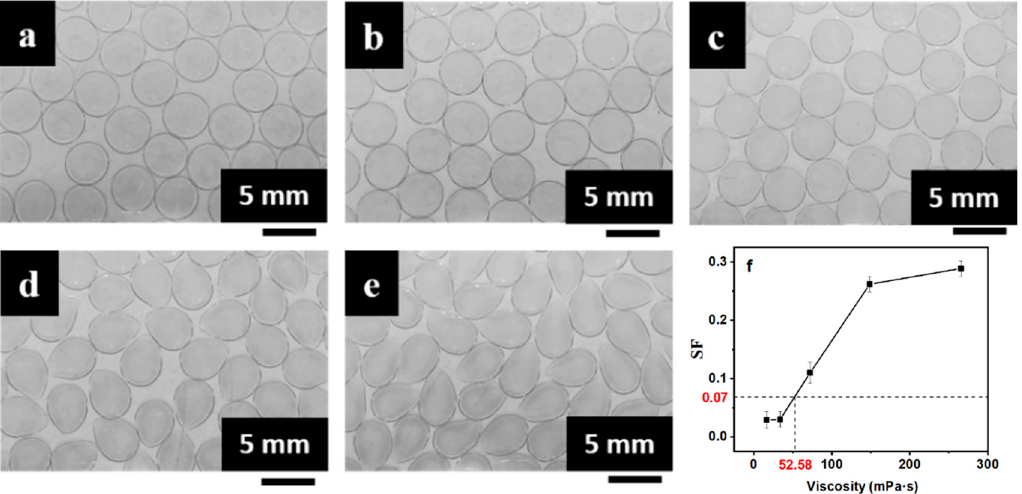
Figure 5. Effect of SA solution viscosity ( a ) 16.2 mPa·s, ( b ) 33.6 mPa·s, ( c ) 72.0 mPa·s, ( d ) 148.5 mPa·s and ( e ) 265.5 mPa·s on ( a) – (e ) morphologies and ( f ) SF of the mm-CaSA-Caps when the viscosity of the CaCl 2 /CMC solution is 917.5 mPa·s. The concentrations of SA were 0.25, 0.5, 0.75, 1.0 and 1.25 wt.%. The concentrations of CaCl 2 was 1.5 wt.%. The concentrations of CMC was 1.5 wt.%.